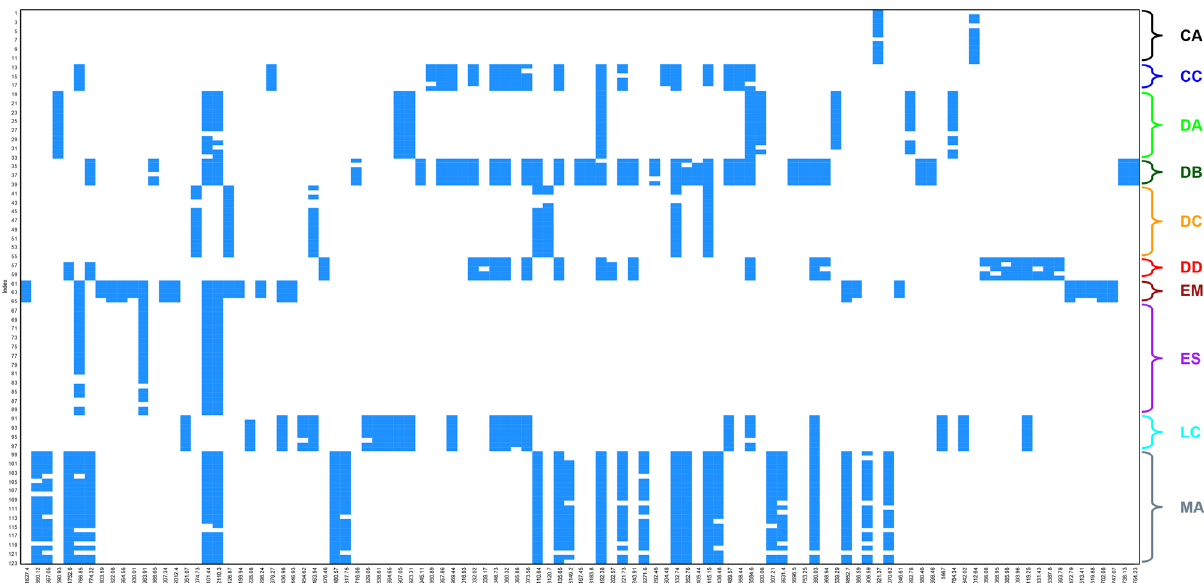
Figure 3. Peak pattern plot of the protein mass spectra of ten Diphyids. X-axis: representative peaks with the highest variation among 123 spectra; Y-axis: number of specimens are displayed in 4 intervals.